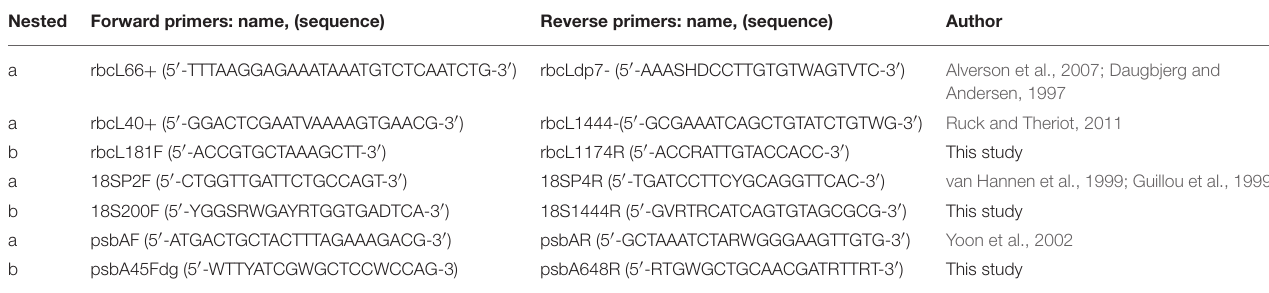
TABLE 3 | Oligonucleotide primer sequences used in the nested amplifications. Nested Forward primers: name, (sequence)